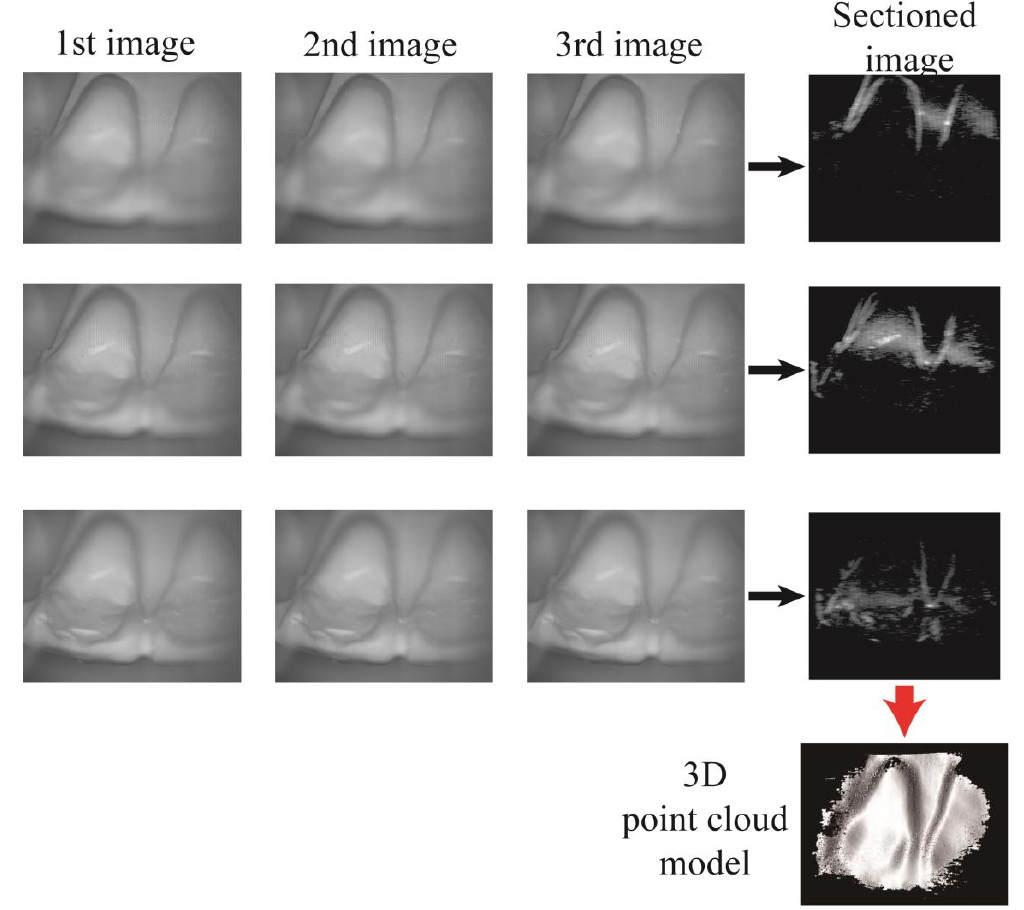
Figure 4. Optical sectioning from the raw images of the dental cast. The intensity of each pixel of the sectioned image is defined in Equation (1). The sectioned images from different focal planes were stacked to reconstruct a 3D point cloud model of the dental cast.